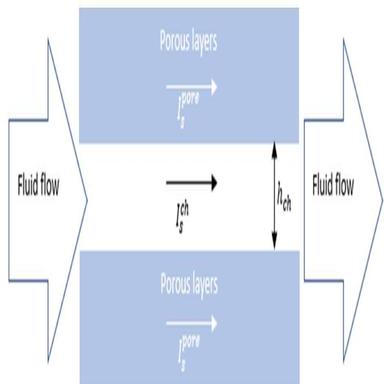
Possible pathways of the streaming current. The total streaming current Is measured by an electrokinetic analyzer is equal to Ich s + 2Ipore s .